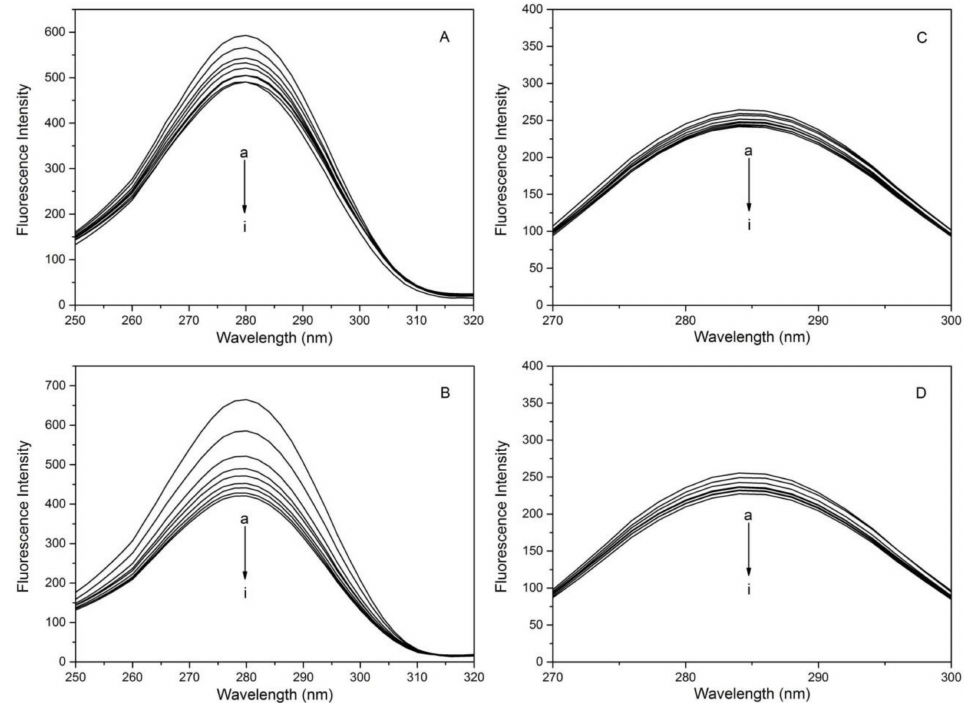
Figure 6. Synchronous fluorescence spectra of HSA in the presence of different concentration of 1,3,6,8-tetrabromocarbazole or 3-bromocarbazole at 298 K: ∆ λ = 60 nm. ( A ): HSA-3-bromocarbazol; ( B ): HSA-1,3,6,8-tetrabromocarbazole) and ∆ λ = 15 nm; ( C ): HSA-3-bromocarbazol; ( D ): HSA-1,3,6,8-tetrabromocarbazole), C HSA = 2 × 10 − 6 M; (a–i) 1,3,6,8-tetrabromocarbazole or 3-bromocarbazole concentrations at 0, 0.1, 0.2, 0.3, 0.4, 0.5, 0.6, 0.7 and 0.8 × 10 − 6 M,